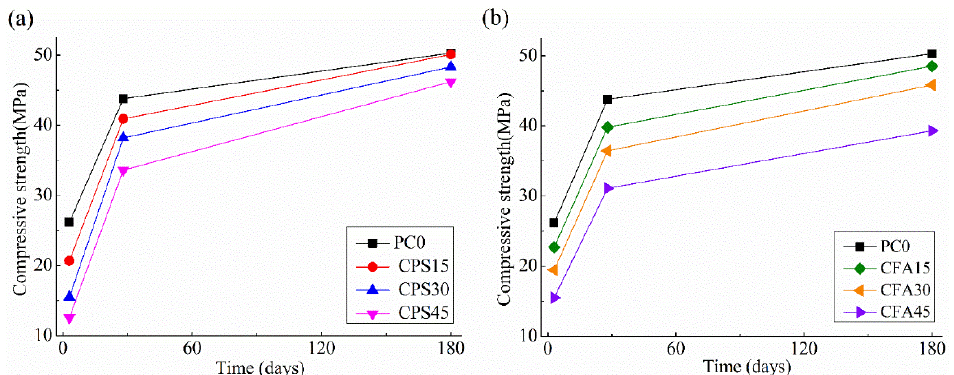
Figure 2. Compressive strengths of hydraulic concretes at 3, 28 and 180 days. ( a ) concretes containing FGPS; ( b ) concretes containing fly ash